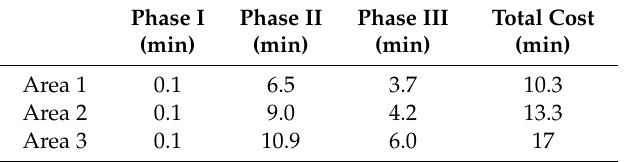
Table 4. Computation time of the proposed method in three Vaihingen sites.